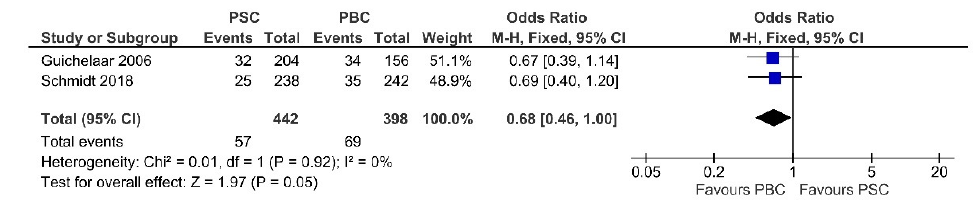
Figure 11. Forest plot assuming a fixed-effects model for fractures PSC vs. PBC [30,33].